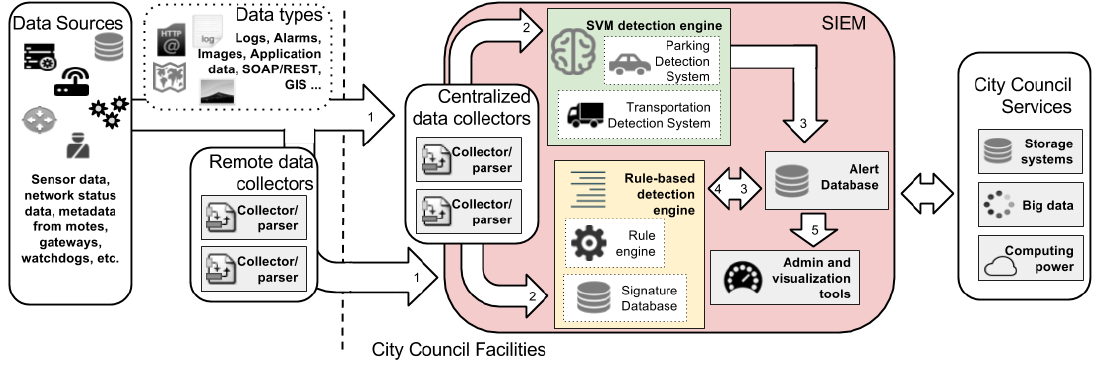
Figure 3. Architecture of the proposed intrusion detection